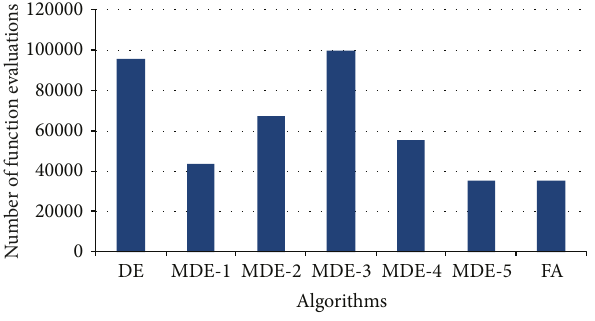
Figure 4: The number of function evaluations done by different algorithms to solve the 4-bus model.